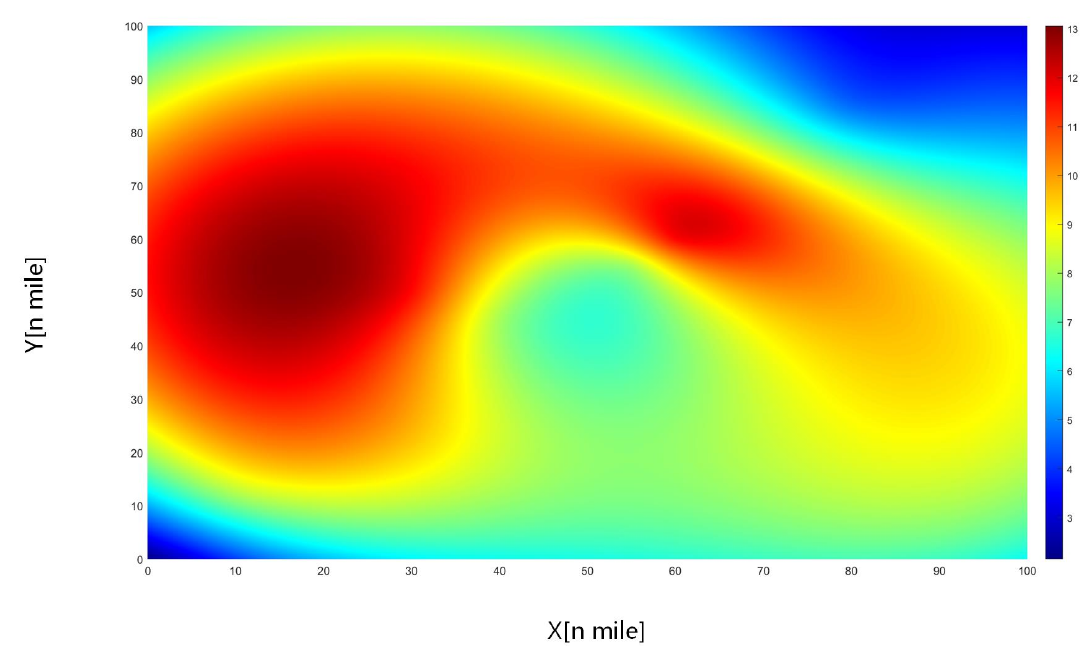
Figure 7. Marine environment map (wind, wave, and flow). Table 2. KCS ship and weight